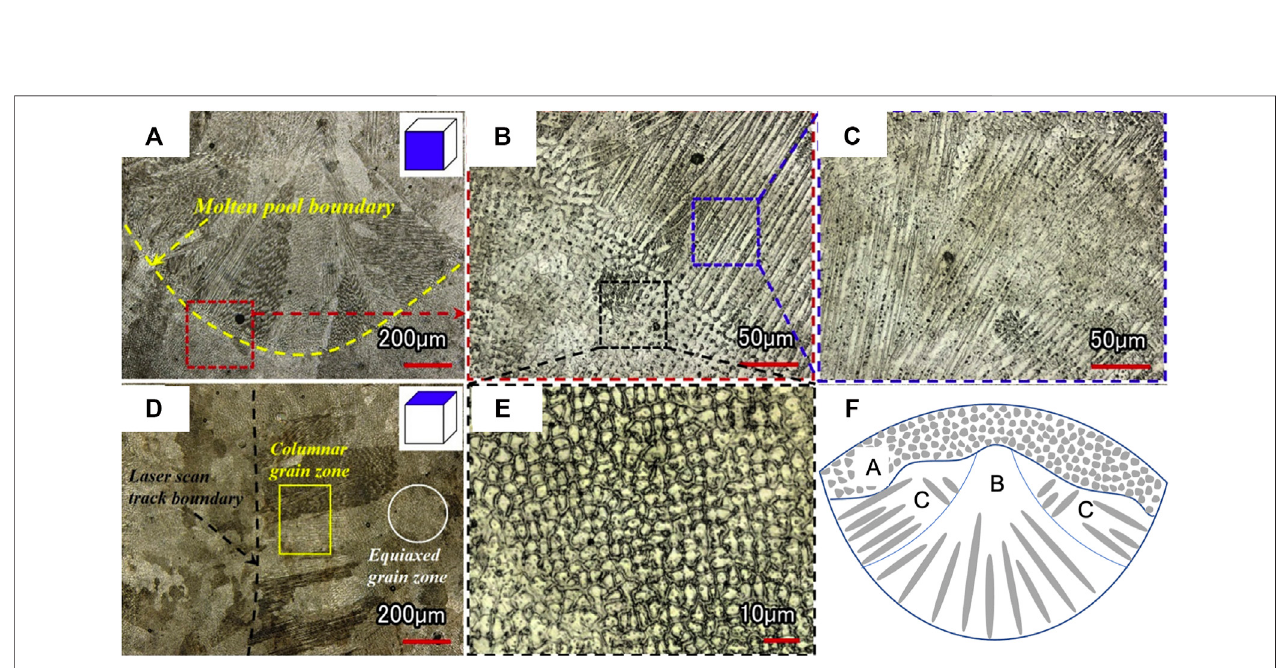
FIGURE 3 | A microstructural evolution during LMD of CoCrFeMnNi MPEA. (A) The microstructural characterization of clad near the melt-pool boundary; (B) A magni fi ed representation of the melt pool boundary with equiaxed and columnar grains near the solid-liquid interface; (C) A magni fi ed view of the epitaxially guided columnar growth from the solid-liquid interface; (D) A top viewof the laser scan track; (E) Amagni fi ed display of (B) reveals the formation ofequiaxed grains at the solid- liquid interfacedue totheconcentratedenergy source atthe start; (F) Aschematic representation ofregion “ A ” equiaxedgrains inthemelt-pool region surrounded by atmosphere, region “ C ” being the location of the melt-pool, with the peak intensity of the laser guided by a gaussian function, and region “ B ” is the overlap region where the melt-pool boundary facilitates a heterogenous nucleation point for columnar grains (Adopted from (Tong et al., 2019)).